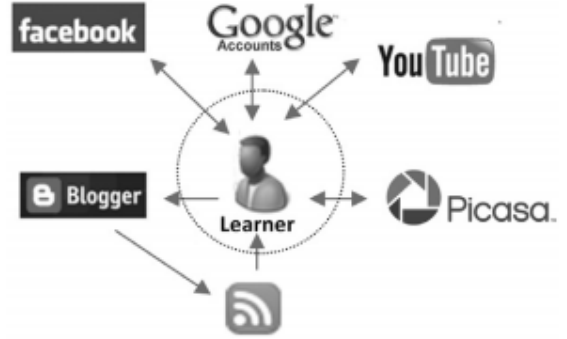
Fig. 1. Online Learning Environment for a